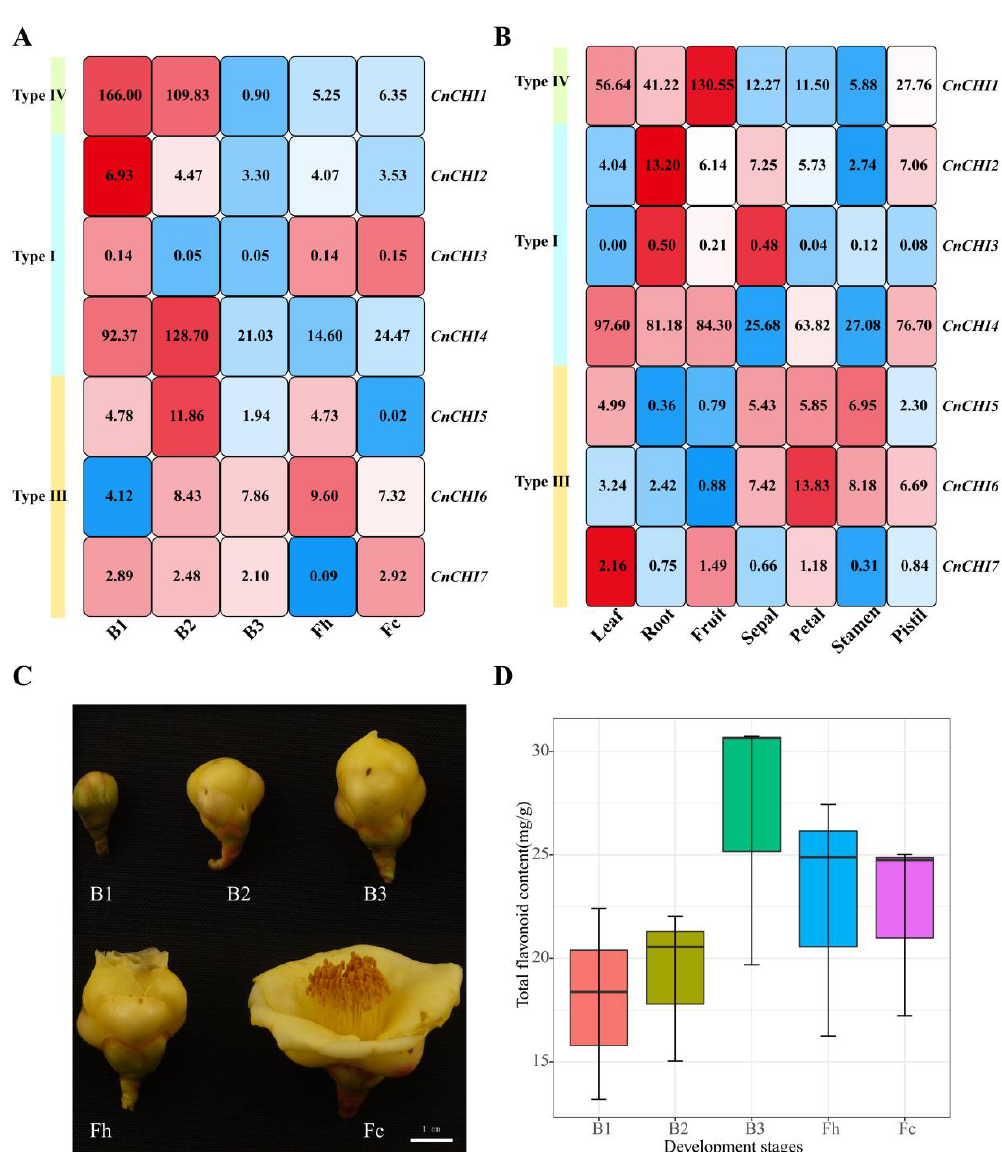
Figure 4. Expression profile of CnCHI and TFC in the petals of C. nitidissima . ( A ) Expression pattern of CnCHI in the petals of C. nitidissima at different developmental stages. B1, B2, and B3 represent buds 10 mm, 20 mm, and 30 mm in diameter, respectively; Fh, half-open flower; Fc, completely open flower. Numbers in the colored fields represent FPKM (Fragments Per Kilobase of transcript per Million mapped reads) values. We normalized the data by standardizing each row and represented them by different colors, with blue representing low expression and red representing high expression ( B ) Expression pattern of CnCHI in the different tissues of C. nitidissima . ( C ) Petals of C. nitidissima at different stages of development. Bars = 1 cm. ( D ) TFC of the petals of C. nitidissima at different stages of development.